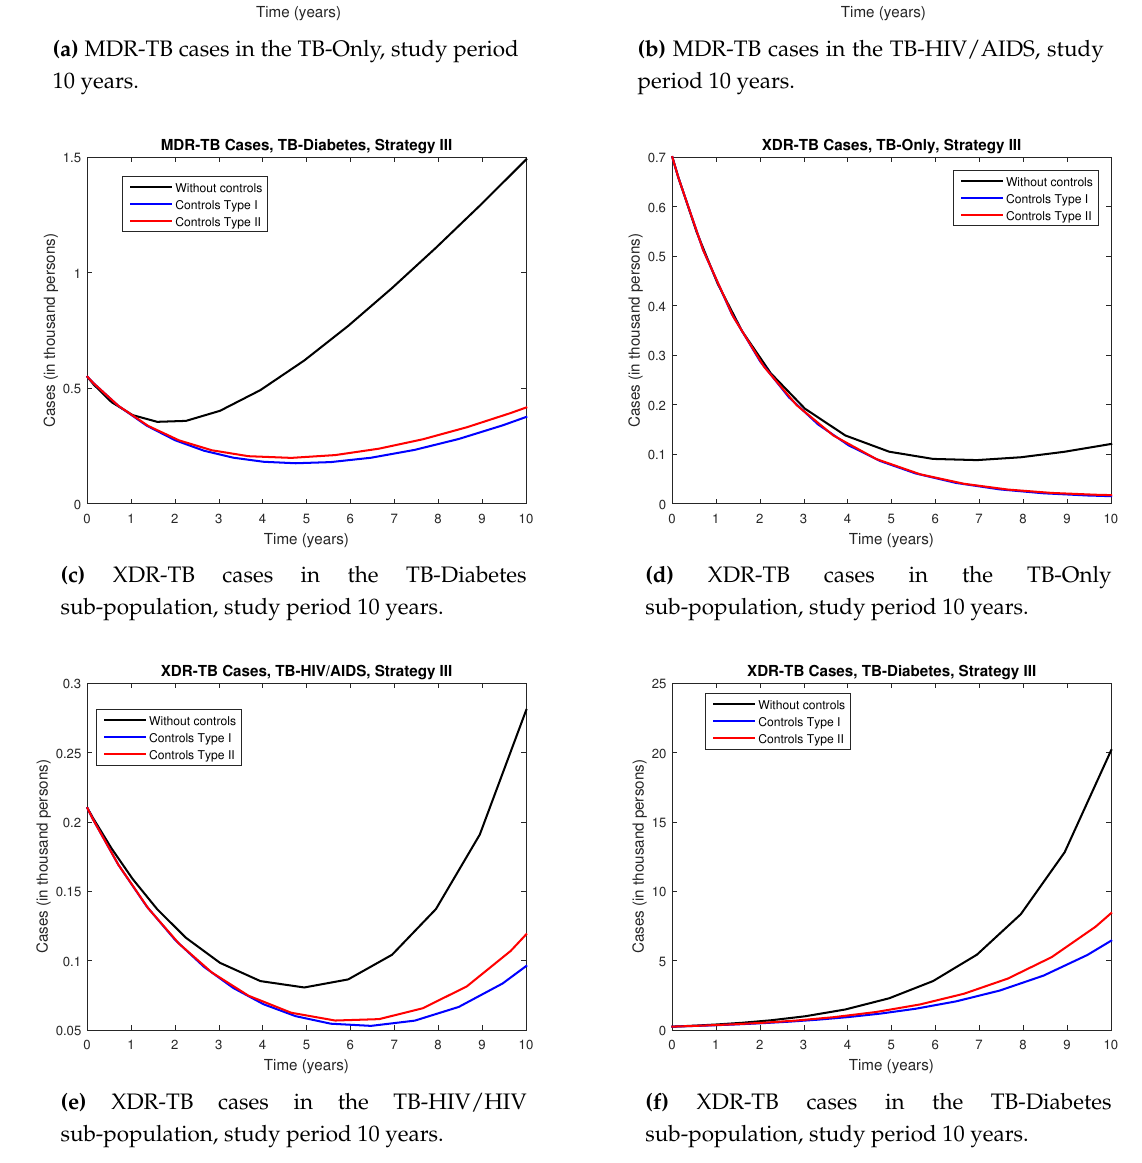
Figure 5. Comparison in the resistance compartments between the types of controls for strategy